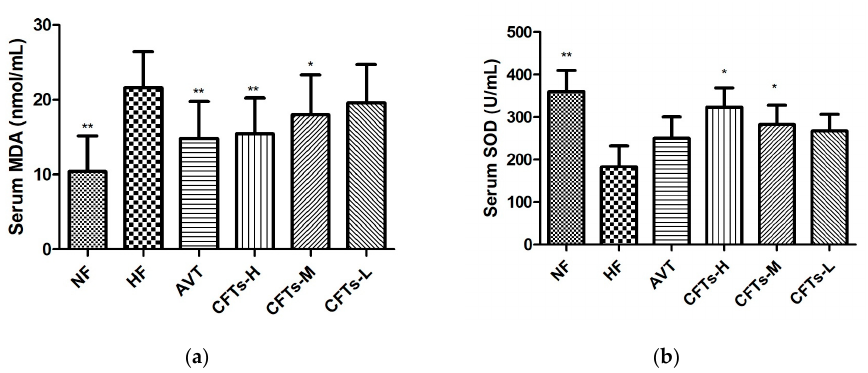
Figure 4. Serum MDA, SOD in rats. ( a ) Serum MDA; ( b ) Serum SOD. (*) Significant difference at p < 0.05 and (**) signficant difference at p < 0.01 VS the HF group. Malondialdehyde (MDA) and